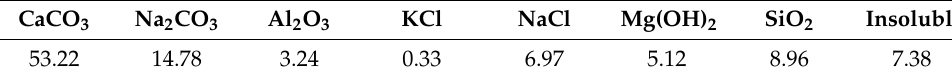
Figure 1. Granulometric distribution of coking coal. The soda residue came from the Paohua alkali factory in Xintai. The components of the soda residue are shown in Table 2. Table 2. Composition analysis of soda residue (%).